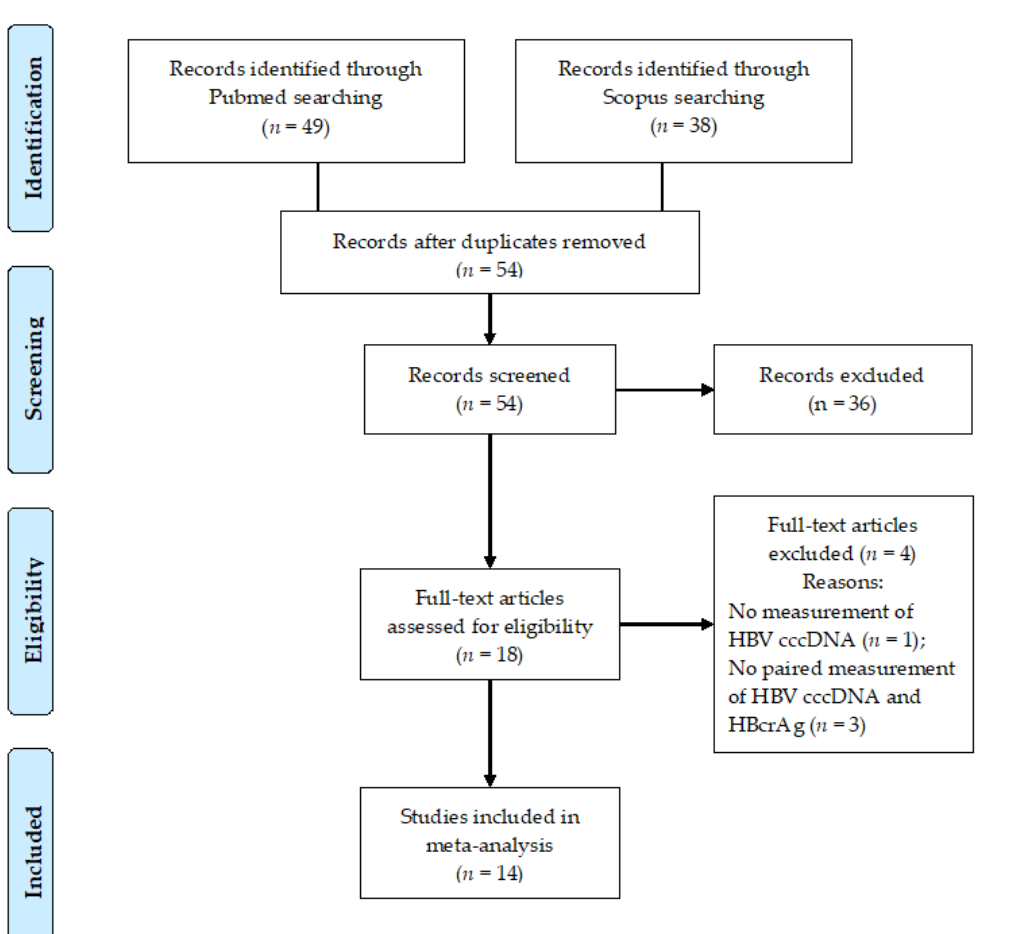
Figure 1. Flow diagram of the study. Abbreviations: covalently-closed-circular DNA (cccDNA), hepatitis B core-related antigen (HBcrAg), hepatitis B virus (HBV), number ( n ).